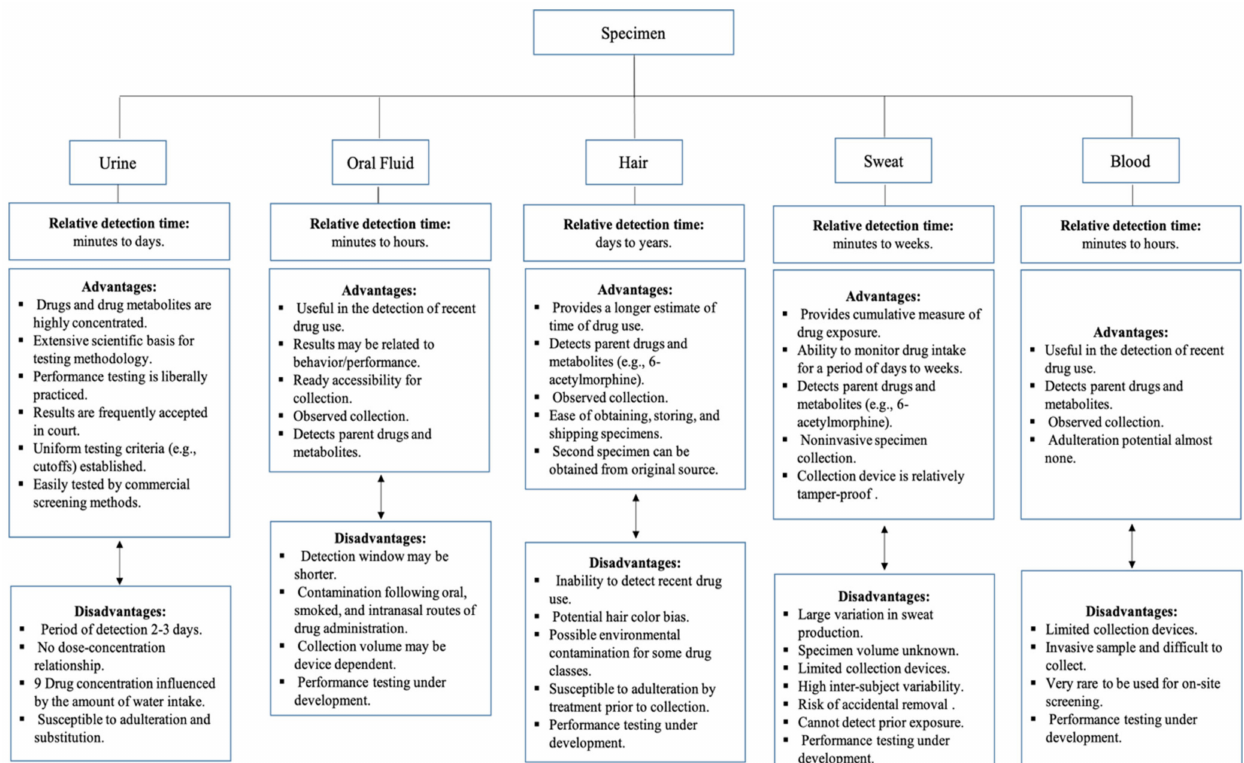
Figure 2. Advantages and disadvantages of various specimens